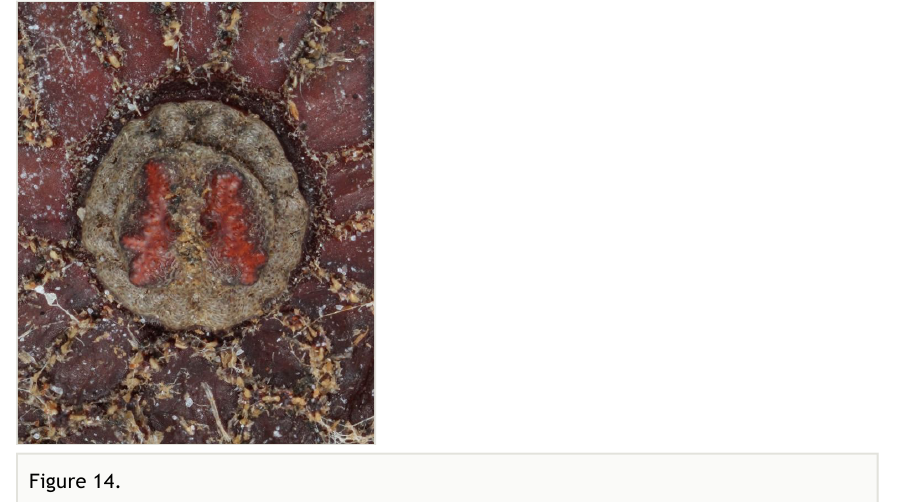
pale green color with metallic luster except for the caudal part of the abdomen, which was dark purple (Fig. 15). This adult specimen was identi fi ed as a female of Microdon katsurai according to Maruyama and Hironaga (2004).